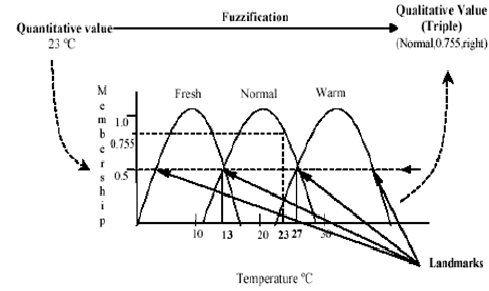
Fig. 1. FIR fuzzification process of ambient temperature